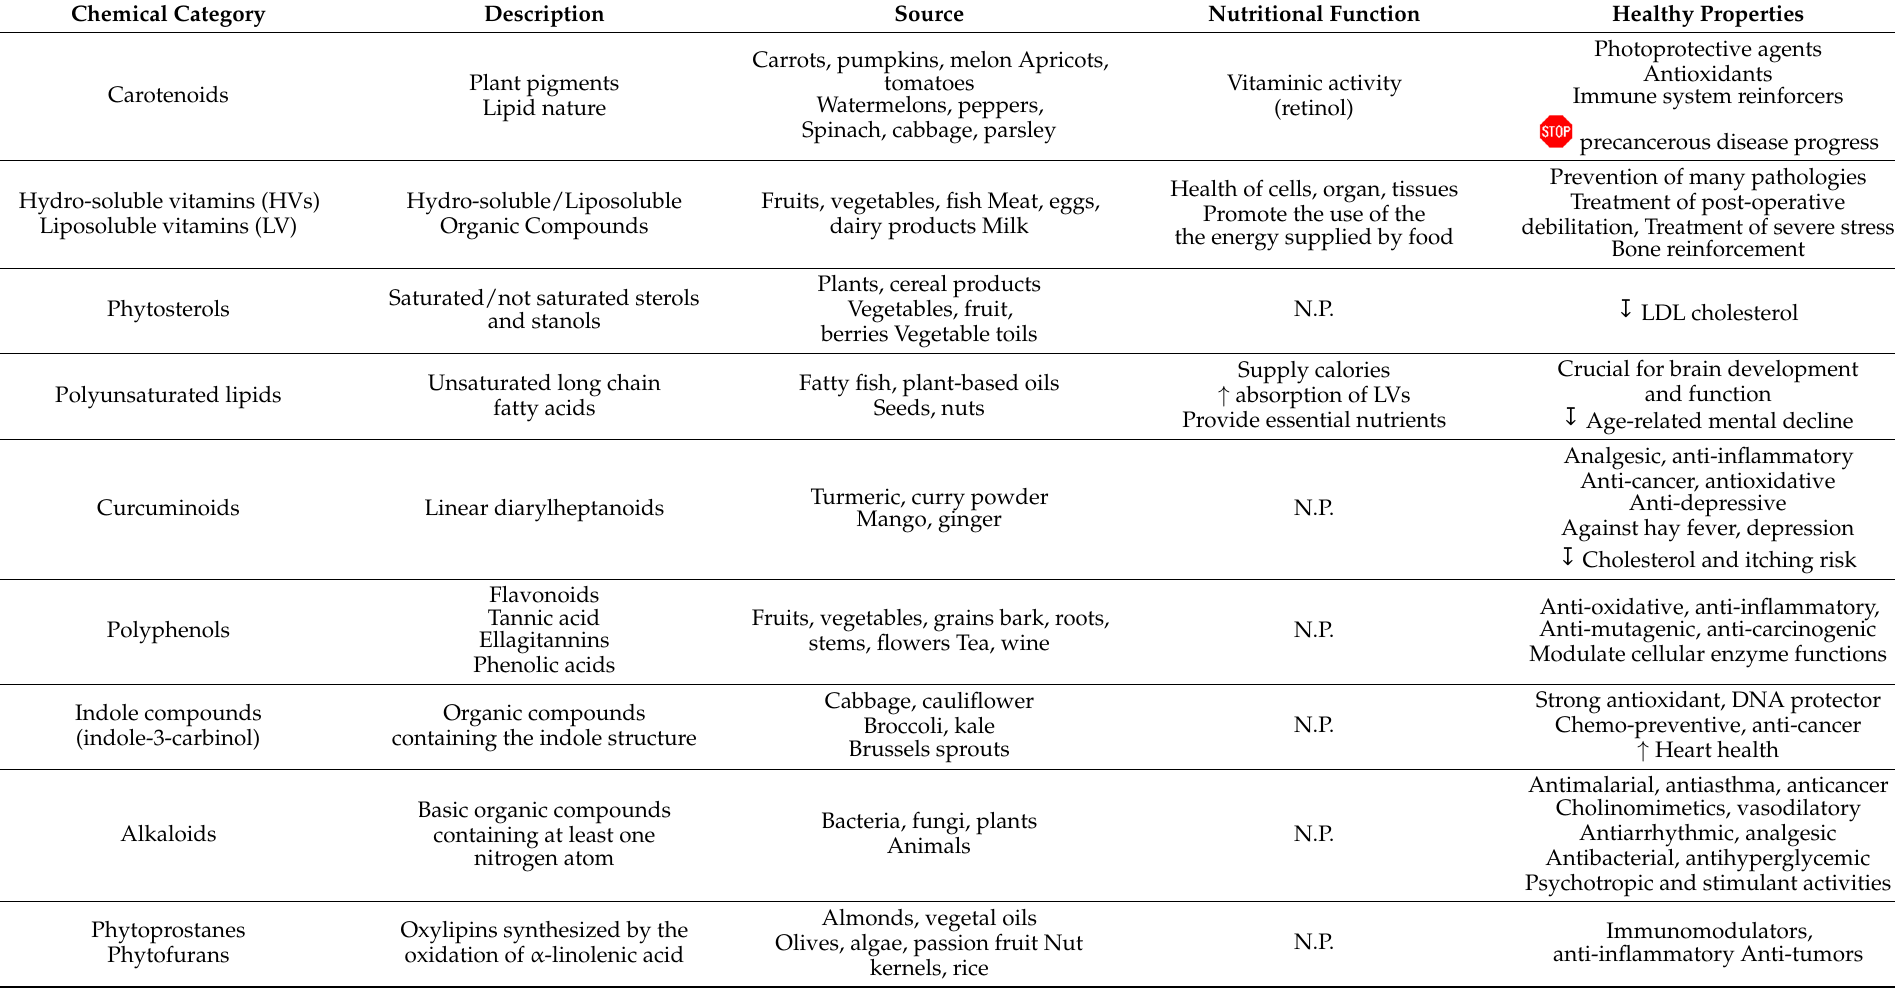
Table 1. The main families of BACs, their sources, nutritional functions and established healthy properties.